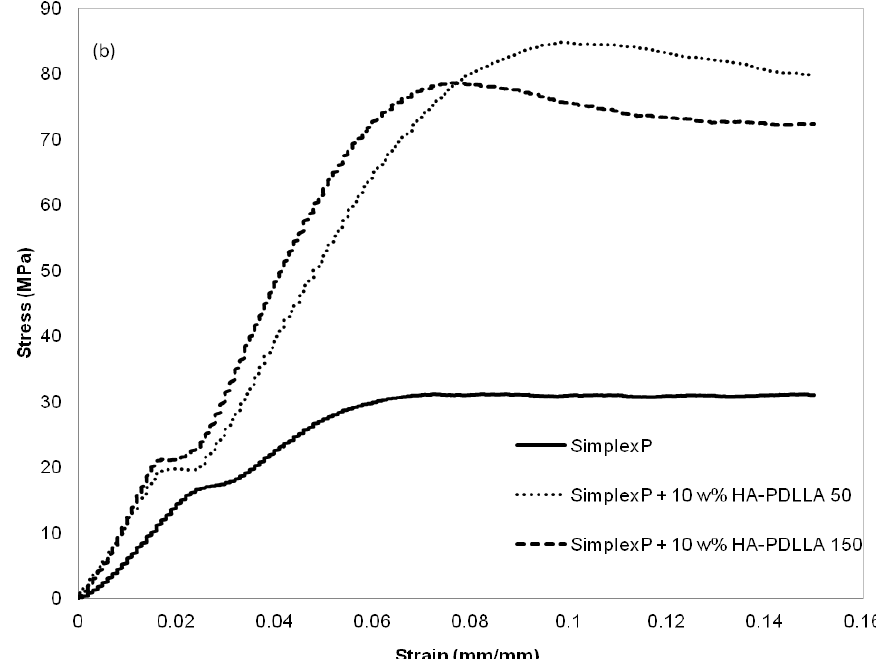
Figure 14. Compression stress-strain curves for standard and modified bone cement formulations exposed to aqueous medium at pH 4. ( a ) control, 0 weeks; ( b ) after exposure for 4 weeks. See Figure S4 for the compression stress–strain curves of the same formulations after exposure for 8 weeks.